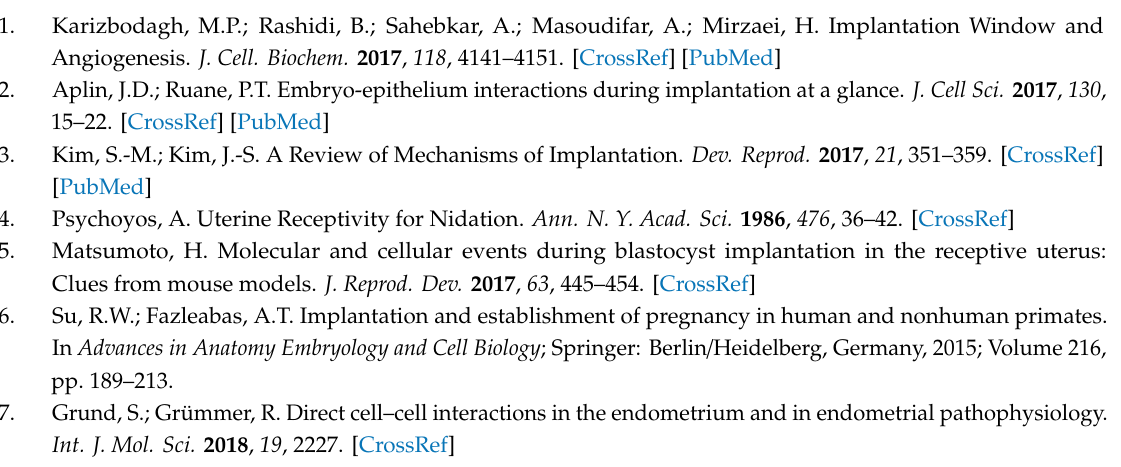
Figure S1: AnxA1 expression and secretion and FPR1 and FPR2 expressions by uterine epithelial cell lineage Ishikawa. Figure S2: AnxA1, Boc-2, cyclosporine H and WRW4 did not modify uterine epithelial cells viability. Figure S3: BeWo spheroid viability. Figure S4: AnxA1 did not modify progesterone and estrogen receptors, HOXA10, and CD61 expressions. Figure S5: Representative image of negative control of embryo implantation